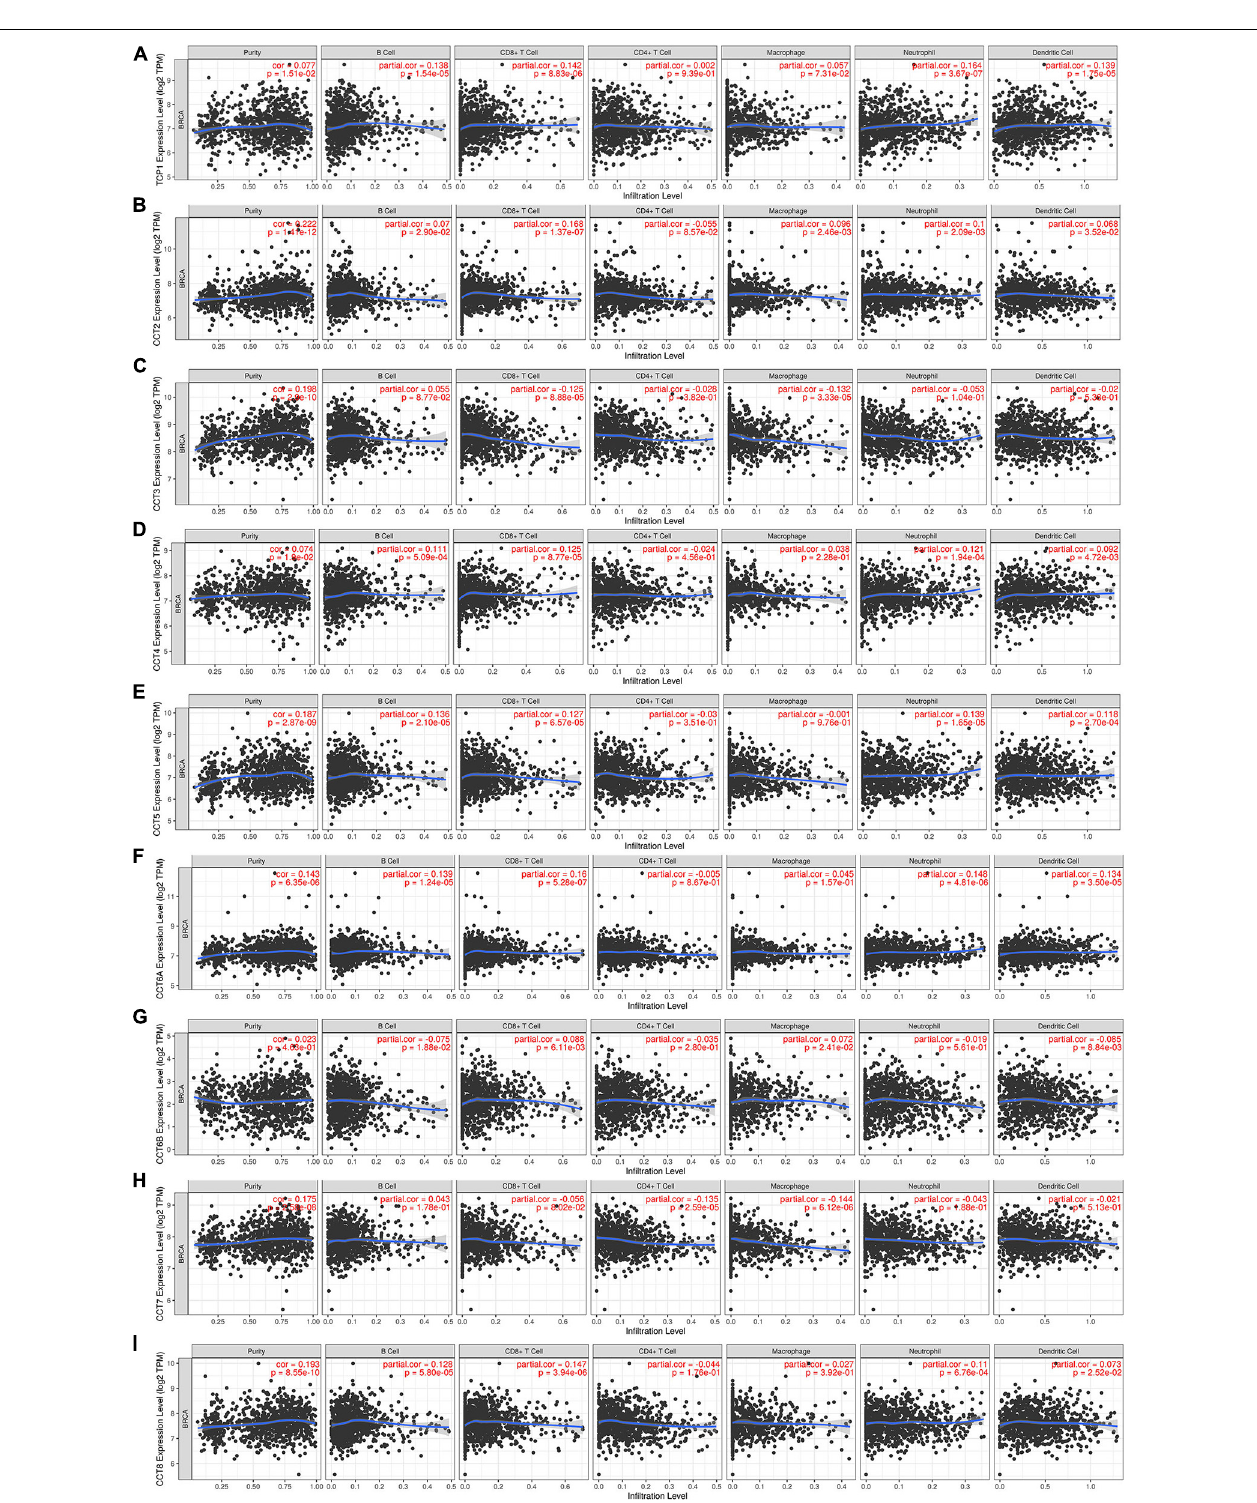
FIGURE 5 | Correlation of eight subunits of the chaperonin TRiC with immune infiltration level in BCa. (A) TCP1 expression had significant positive correlations with infiltrating levels of CD4+ T cells. (B) CCT2 expression had significant correlations with infiltrating levels of CD4+ T cells, macrophages, neutrophils, and dendritic cells in GC. (C) CCT3 expression was significantly related to infiltrating levels of CD4+ T cells and macrophages in GC but no significant correlation with infiltrating level of B cells. (D) CCT4 expression had significant positive correlations with infiltrating levels of CD4+ T cells and macrophages in GC. (E) CCT5, (F) CCT6A, (G) CCT6B, (H) CCT7, and (I)